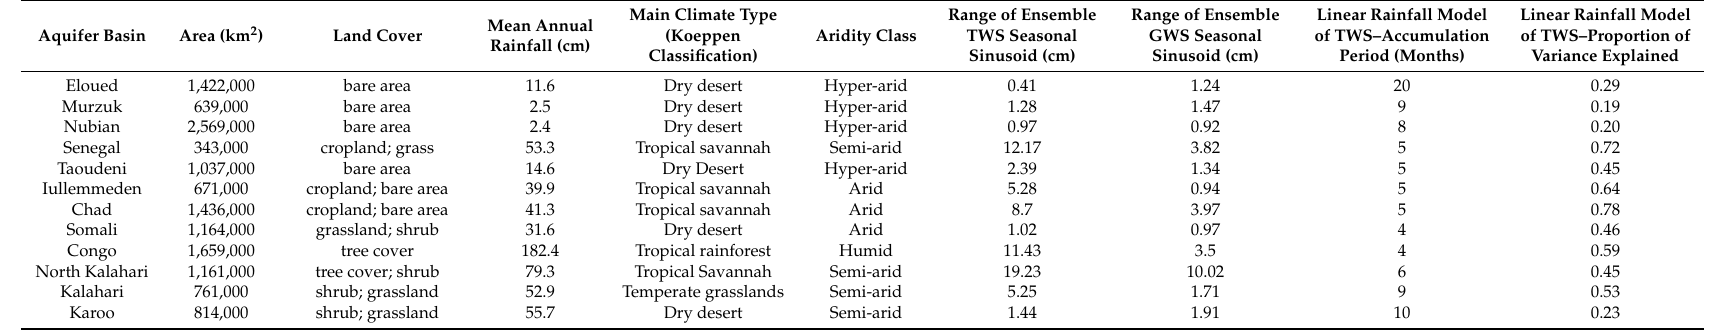
Table 1. Comparison of the average annual rainfall, amplitude of seasonal TWS changes, the amplitude of estimated groundwater storage (GWS) changes, and average annual estimated GWS for each basin. Average annual rainfall, spatial area, aridity index, main climate type, and land use are also compared for each